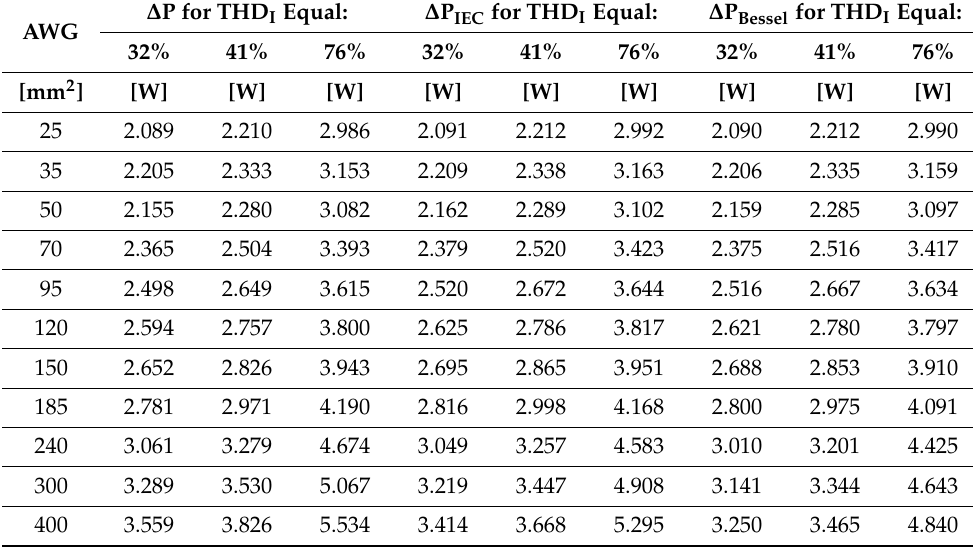
Table 1. The cable power losses for the 25% rated cable current. ∆ P for THD I Equal: AWG